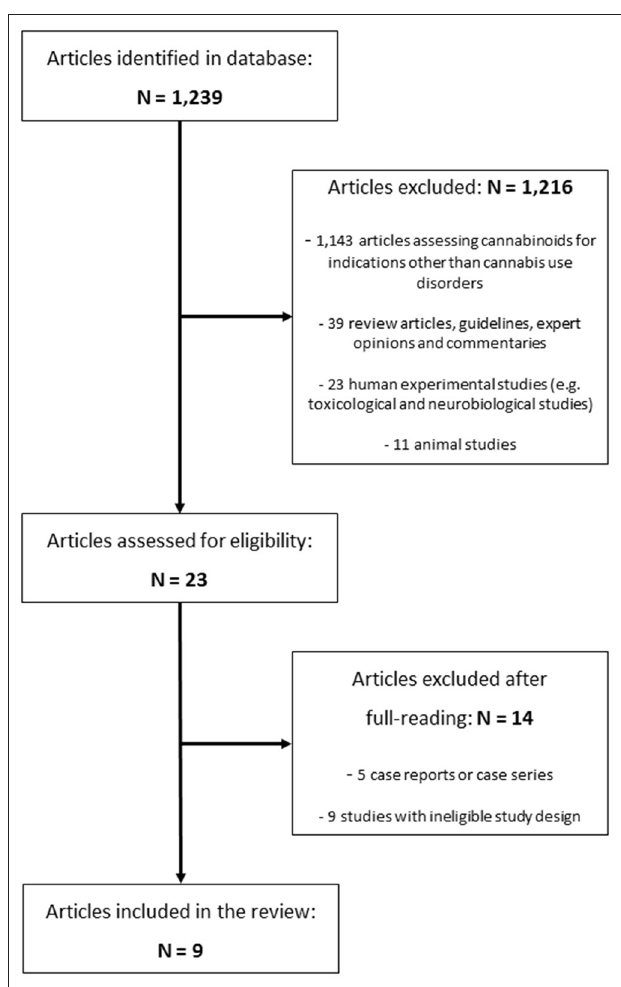
FIGURE 1 | PRISMA flow diagram of study